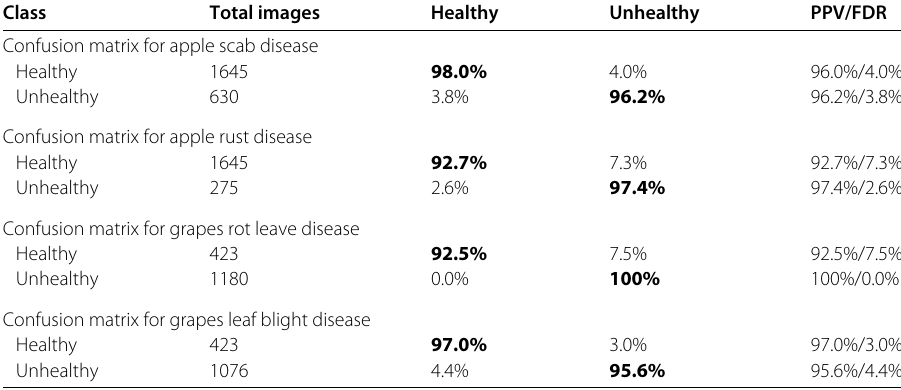
Table 6 Confusion matrix of all experiments for selected diseases Class Total images Healthy Unhealthy PPV/FDR Confusion matrix for apple scab disease Healthy 1645 98.0% 4.0% 96.0%/4.0% Unhealthy 630 3.8% 96.2% 96.2%/3.8% Confusion matrix for apple rust disease Healthy 1645 92.7% 7.3% 92.7%/7.3% Unhealthy 275 2.6% Confusion matrix for grapes rot leave disease Healthy Unhealthy Confusion matrix for grapes leaf blight disease Healthy